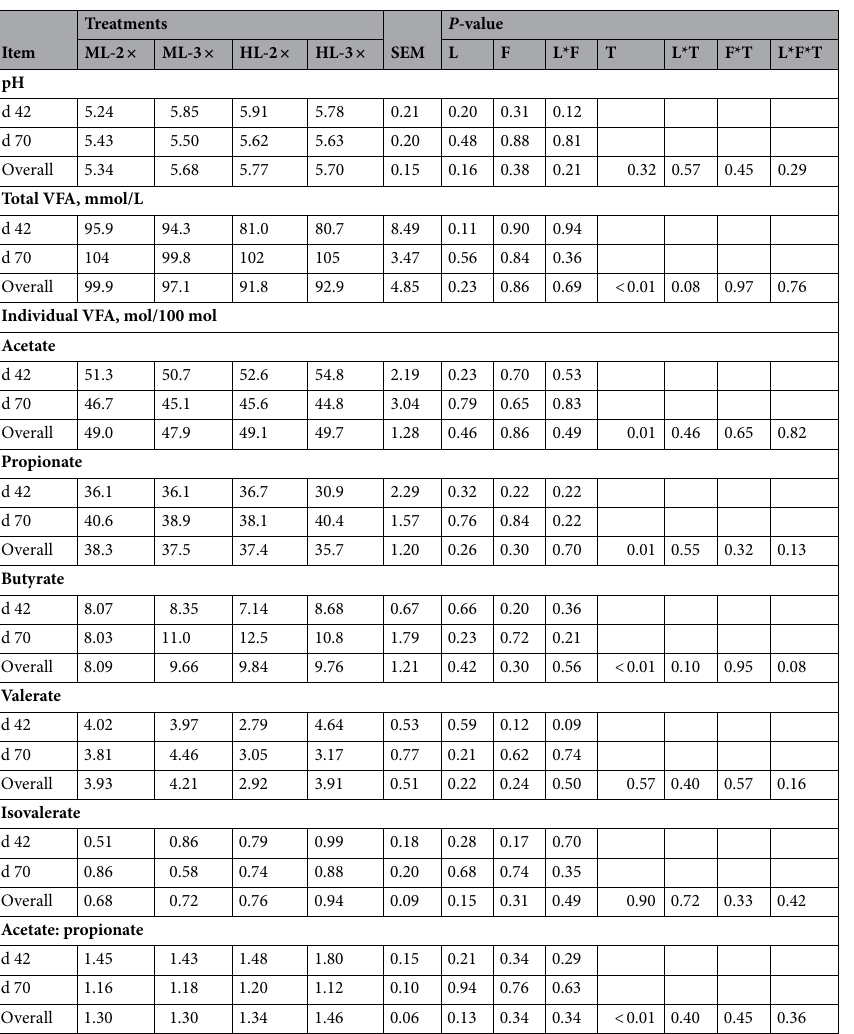
Table 5. Effects of milk feeding level (medium vs. high) and milk feeding frequency (2 vs. 3) on rumen fermentation of dairy calves during days of 42, 70, and overall (n = 12 calves/treatment). 1 Treatments including level; F = feeding frequency, L × F = feeding level × feeding frequency, T = time, L × T = feeding level × time, F × T = feeding frequency × time, and L × F × T = feeding level × feeding frequency ×